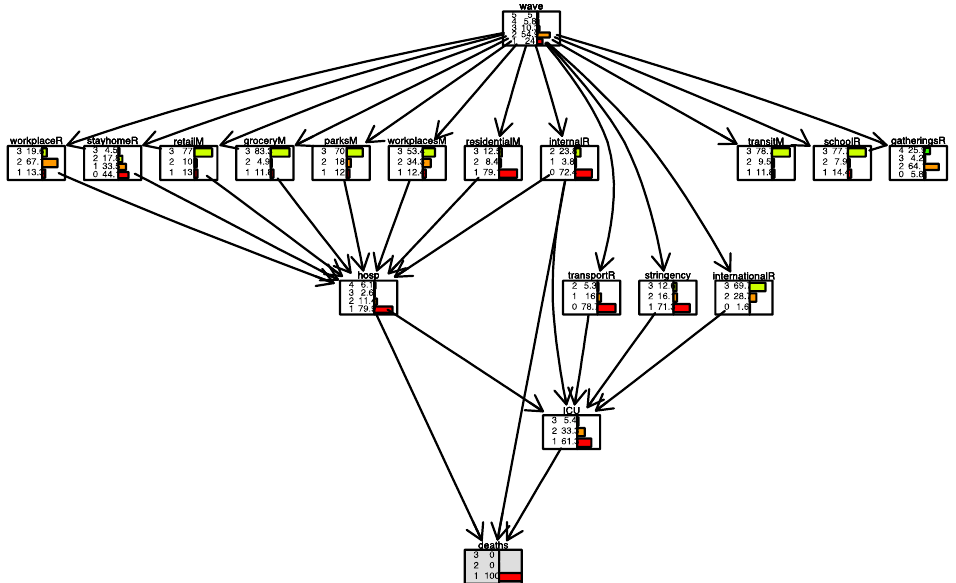
Figure 9. Scenario for Italy when international movements restriction is set to 3. International movement restriction node is highlighted in grey Some restriction measure variables behave in unexpected directions. For example, mobility behaviour changes with no direct reference to deaths, and the internal movement restriction variable changed from 23.8% at the maximum rate ( = 2) when deaths were minimum ( = 1) to 83.3% when deaths were maximum ( = 3), meaning that fewer deaths imply less movement. This could be explained by the fact that in Italy restriction measures have been in places for long periods, even when deaths increased or decreased. Therefore, movements remained low even with a low number of deaths or high with a large number of deaths.